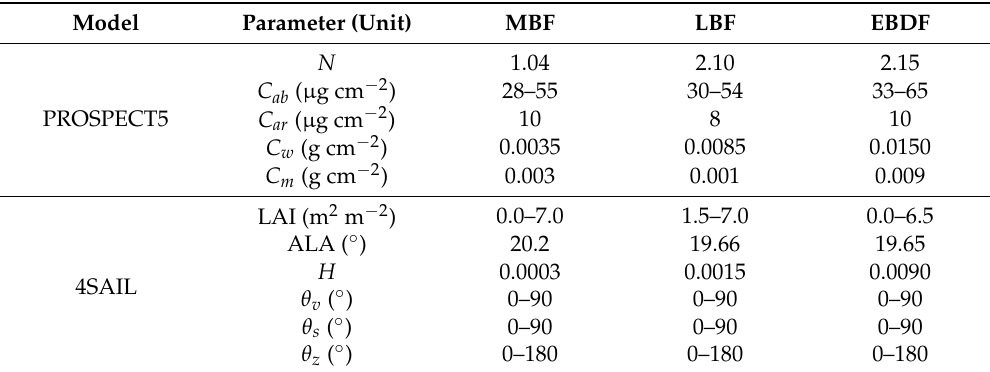
Table 2. Principal parameters of the PROSAIL